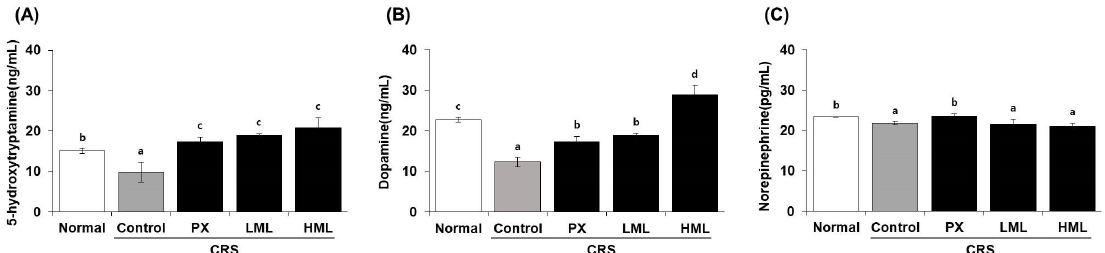
Figure 3. Effect of the ML extracts on monoamines in brain tissue. Mice were restrained for 2 h for 28 consecutive days after the treatments. The neurotransmitters (A) 5-HT, (B) DA, and (C) NE were measured by ELISA. Data represent means ± SEM ( n = 5). Different letters (a–d) above the bars indicate significant differences at p < 0.05. CRS—chronic restraint stress; PX—paroxetine; LML—low-concentration mustard leaf; HML—high-concentration mustard leaf; 5-HT—serotonin; DA—dopamine; NE—norepinephrine.